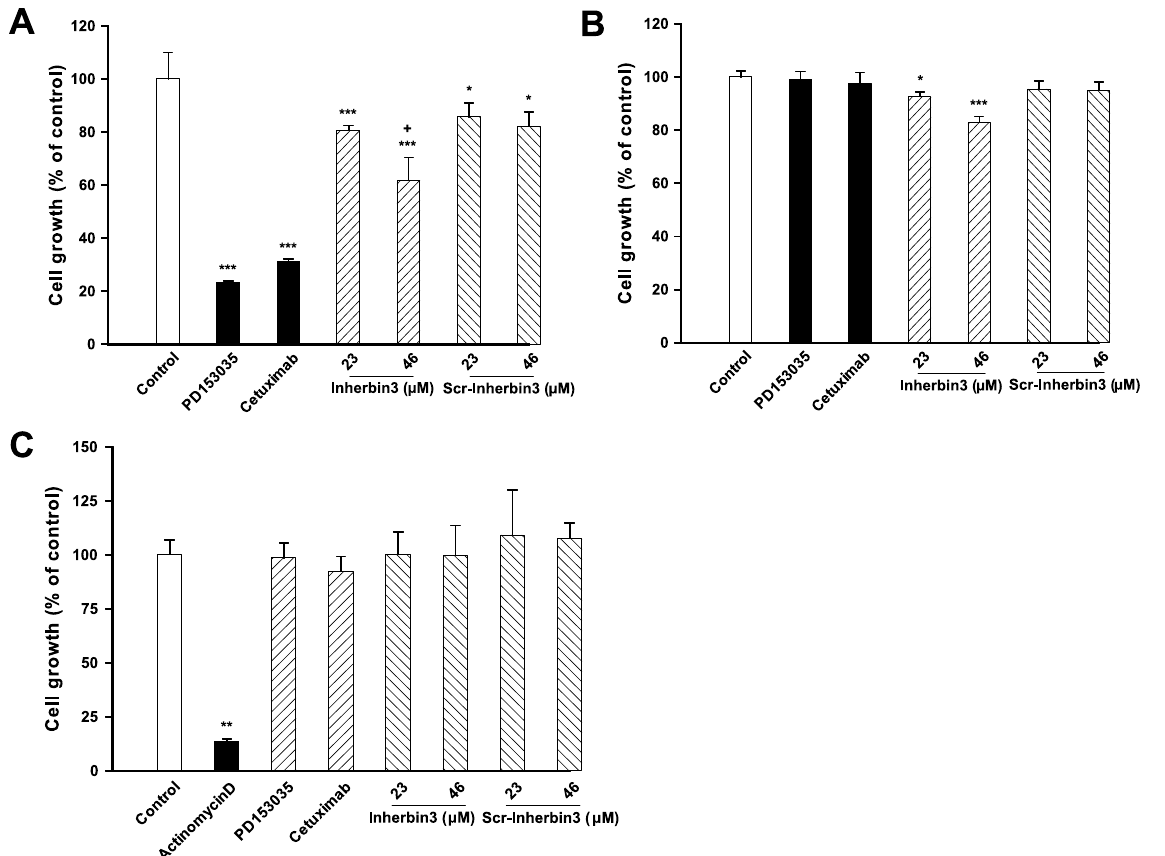
Fig. 5. Effect of Inherbin3 on in vitro cell growth of HN5 and A549 cells. HN5 cells (A), A549 cells (B) or Cos-7 cells (C) were seeded in full medium (containing 10% fetal calf serum) and treated with the indicated doses of Inherbin3, Scr-Inherbin3, 100 nM PD153035, or 50 µM Cetuximab. Cells were grown for 3 days, and cell growth was measured with MTS staining. Data are expressed as mean ± SEM of 6–8 independent experiments. ∗ p < 0 . 05, ∗∗ p < 0 . 01, ∗∗∗ p < 0 . 001, compared with untreated cells (control) (repeated-measures analysis of variance followed by Dunnett’s post hoc test). + p < 0 . 05, significant difference compared with Scr-Inherbin3 (46 µM) (Student’s paired t